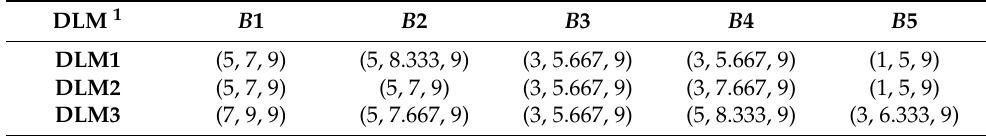
Table 5. Combined decision matrix for three distance learning course information tools usage assessment by five criteria.